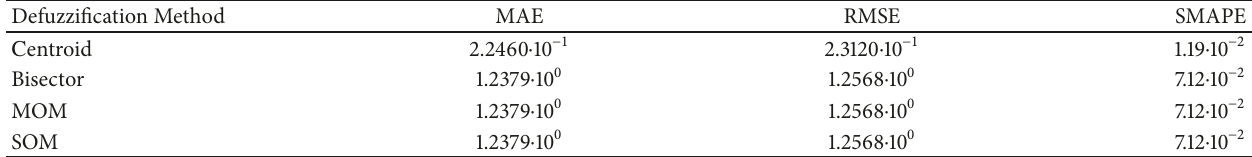
Table 3: Results of imitating simulation of a fuzzy ship collision prevention system in a heavy traffic zone proposed in [35]. Defuzzification Method